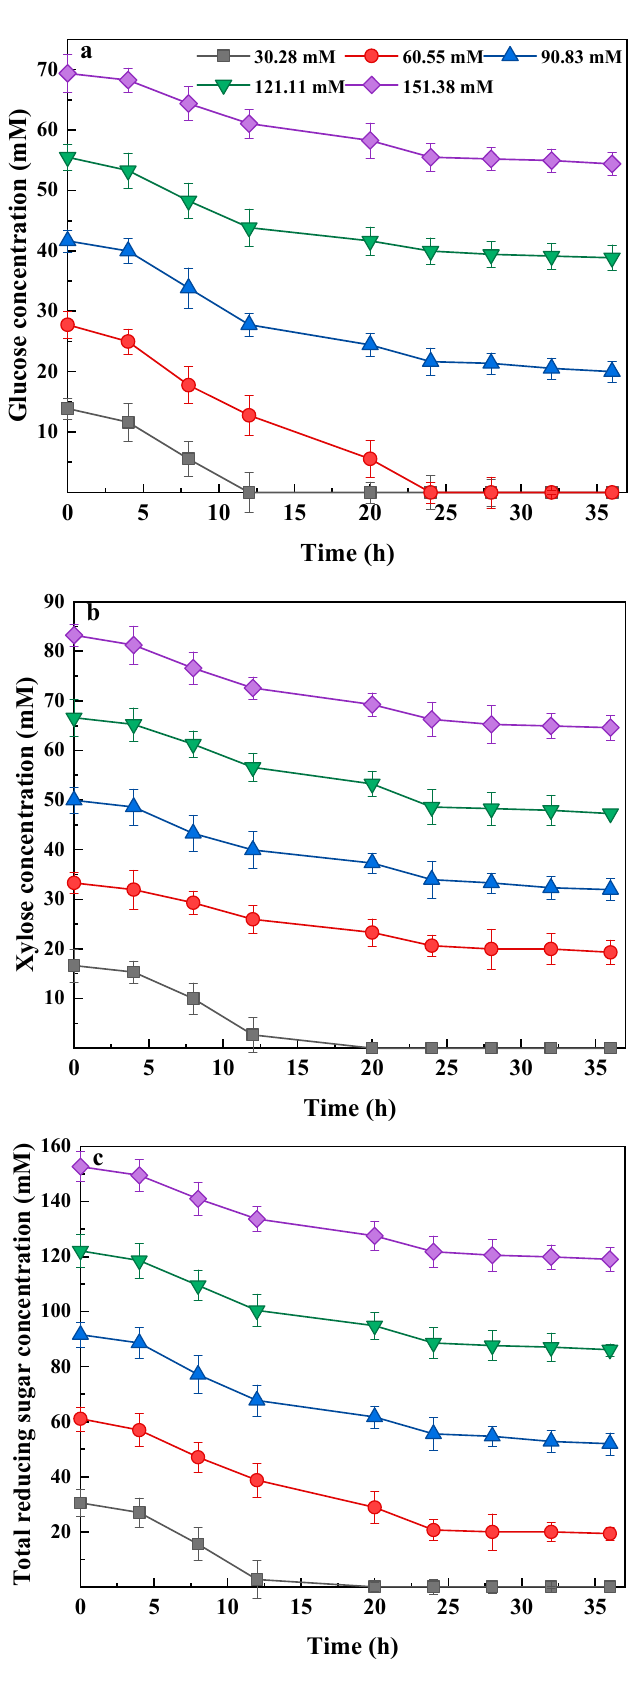
Figure 6. Residue substrate concentration during bio-hydrogen production at varying glucose–xylose concentrations. ( a ) Residue glucose concentration; ( b ) Residue xylose concentration; ( c ) Residue glucose and xylose concentration.